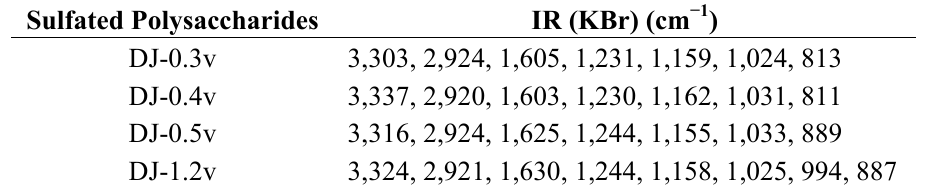
Table 2. IR spectra data of sulfated polysaccharides from the brown seaweed D. justii. Sulfated